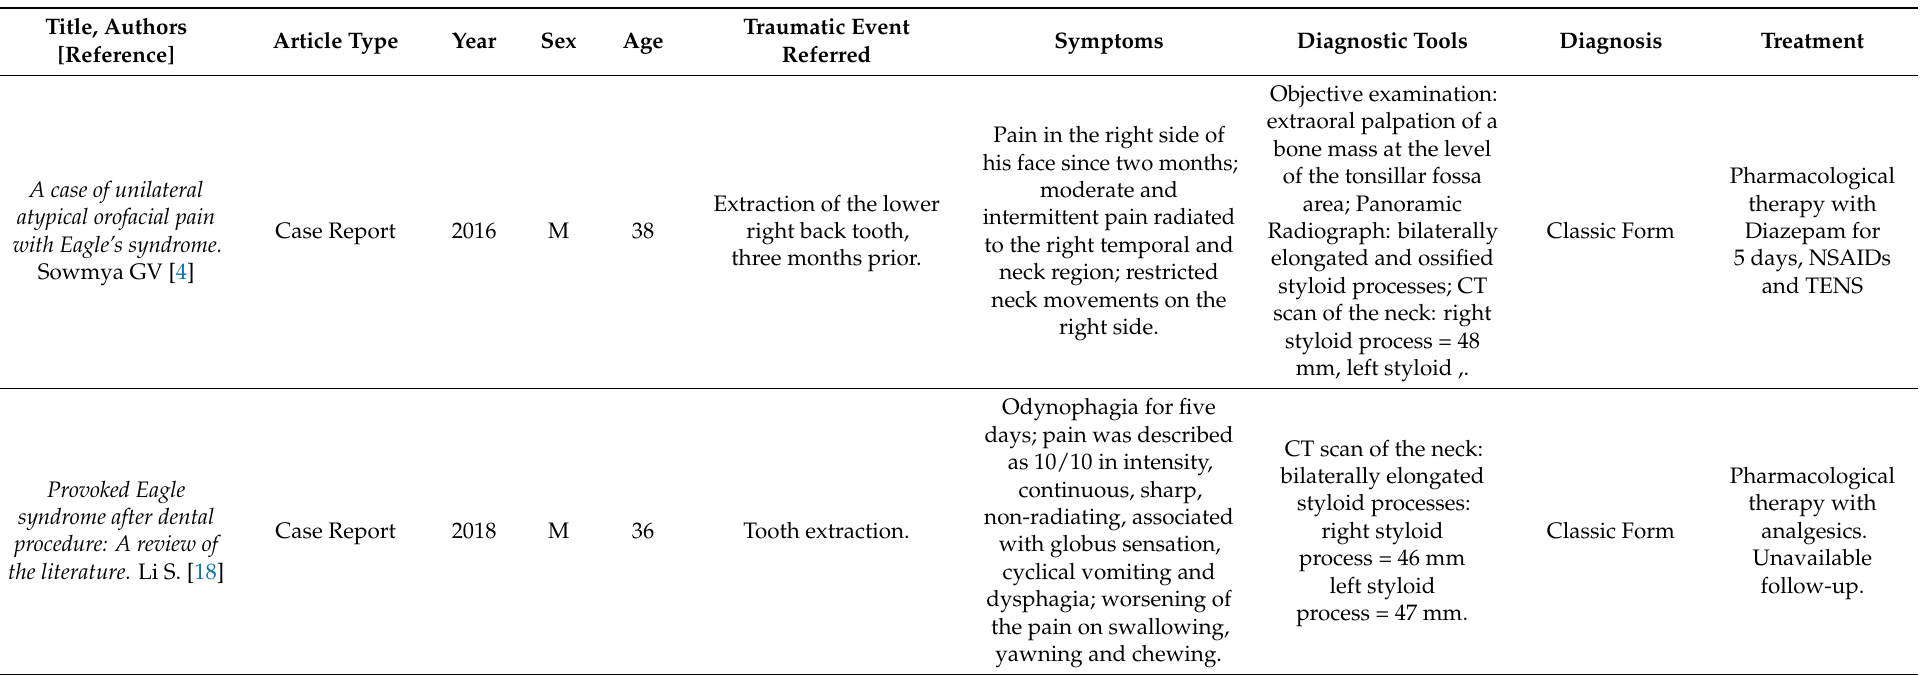
Table 4. Summarized correlation between Eagle Syndrome and extractive dental